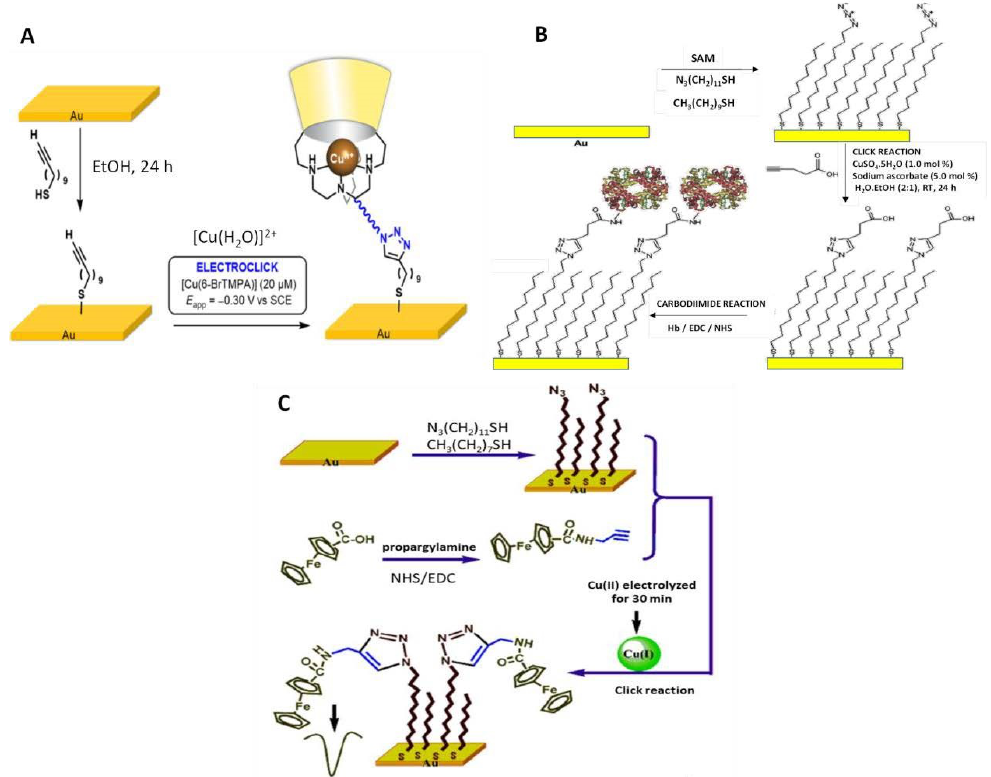
Figure 2. Strategy for electroclick grafting of [Cu(H 2 O)] 2+ on gold electrodes modified with alkyne-terminated alkane thiols ( A ); Hb-functionalization of Au surface via click chemistry on mixed SAMs ( B ); fundamentals of copper(II) detection involving CuAAC electroclick ( C ). Reprinted from